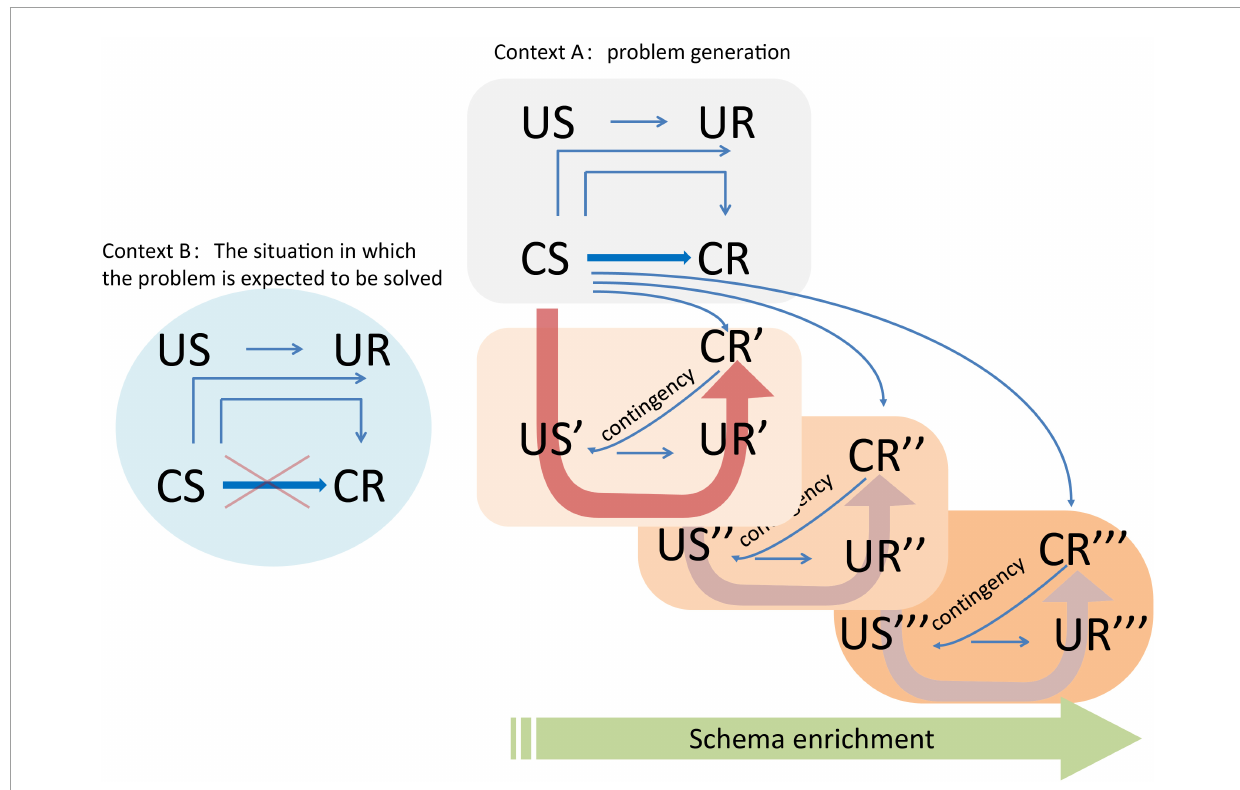
FIGURE1 Schema-enrichment-based cognitive reappraisal technique. Context A represents the situation in which the original emotional problem arises. On the other hand, and Context B is the setting where the problem is expected to be resolved. The unconditioned stimulus (US) is a stimulus that holds significance for the survival and reproduction of individuals. The unconditioned response (UR) refers to an innate instinctive response that is triggered by the US. The conditioned stimulus (CS) is a neutral stimulus that consistently accompanies the US and trigger an individual’s learned response known as the conditioned response (CR), which functionally replaces the UR when the individual learns that the occurrence of the CS predicts the occurrence of the US. Contingency refers to the "if-then" relationship between two events (Bouton, 2016) and involves the probability of the occurrence of an US when a CS is present (Battaglia et al., 2020). The connections between the different elements are represented by blue arrows in the figure, where thick blue arrows depict higher order paths and thin arrows represent lower order paths. The red crosses indicate updates to path connections where the original path is irrelevant in the current situation. The background with different colors represents changes in scenarios, and the heavy arrow indicates the formation of a new connection (new schema). The green arrow signifies the enrichment of the schema resulting from the new connection formed during the training process, during which new CRs (annotated with strokes) lead to new USs and thus new